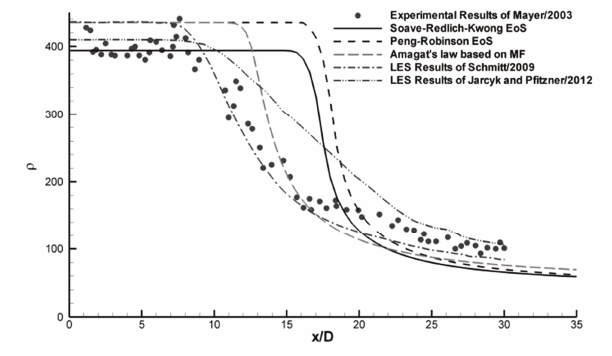
Fig. 6. Axial density distribution for transcritical case